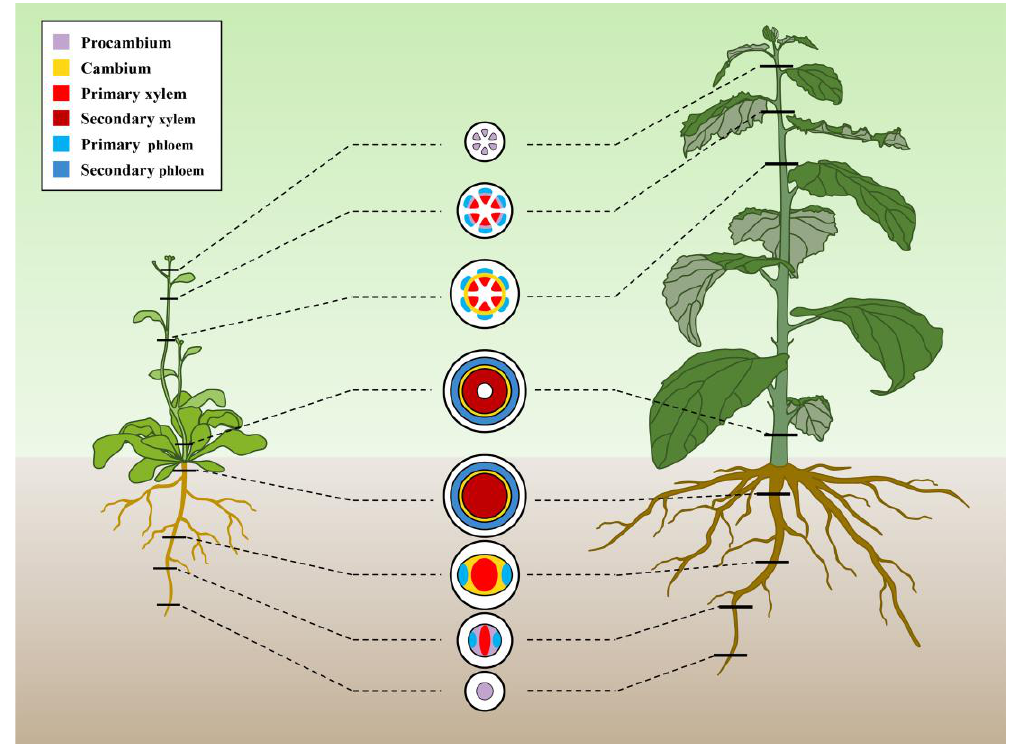
Figure 1. Schematic representation of xylem development in vascular plants represented by Arabidopsis and poplar.